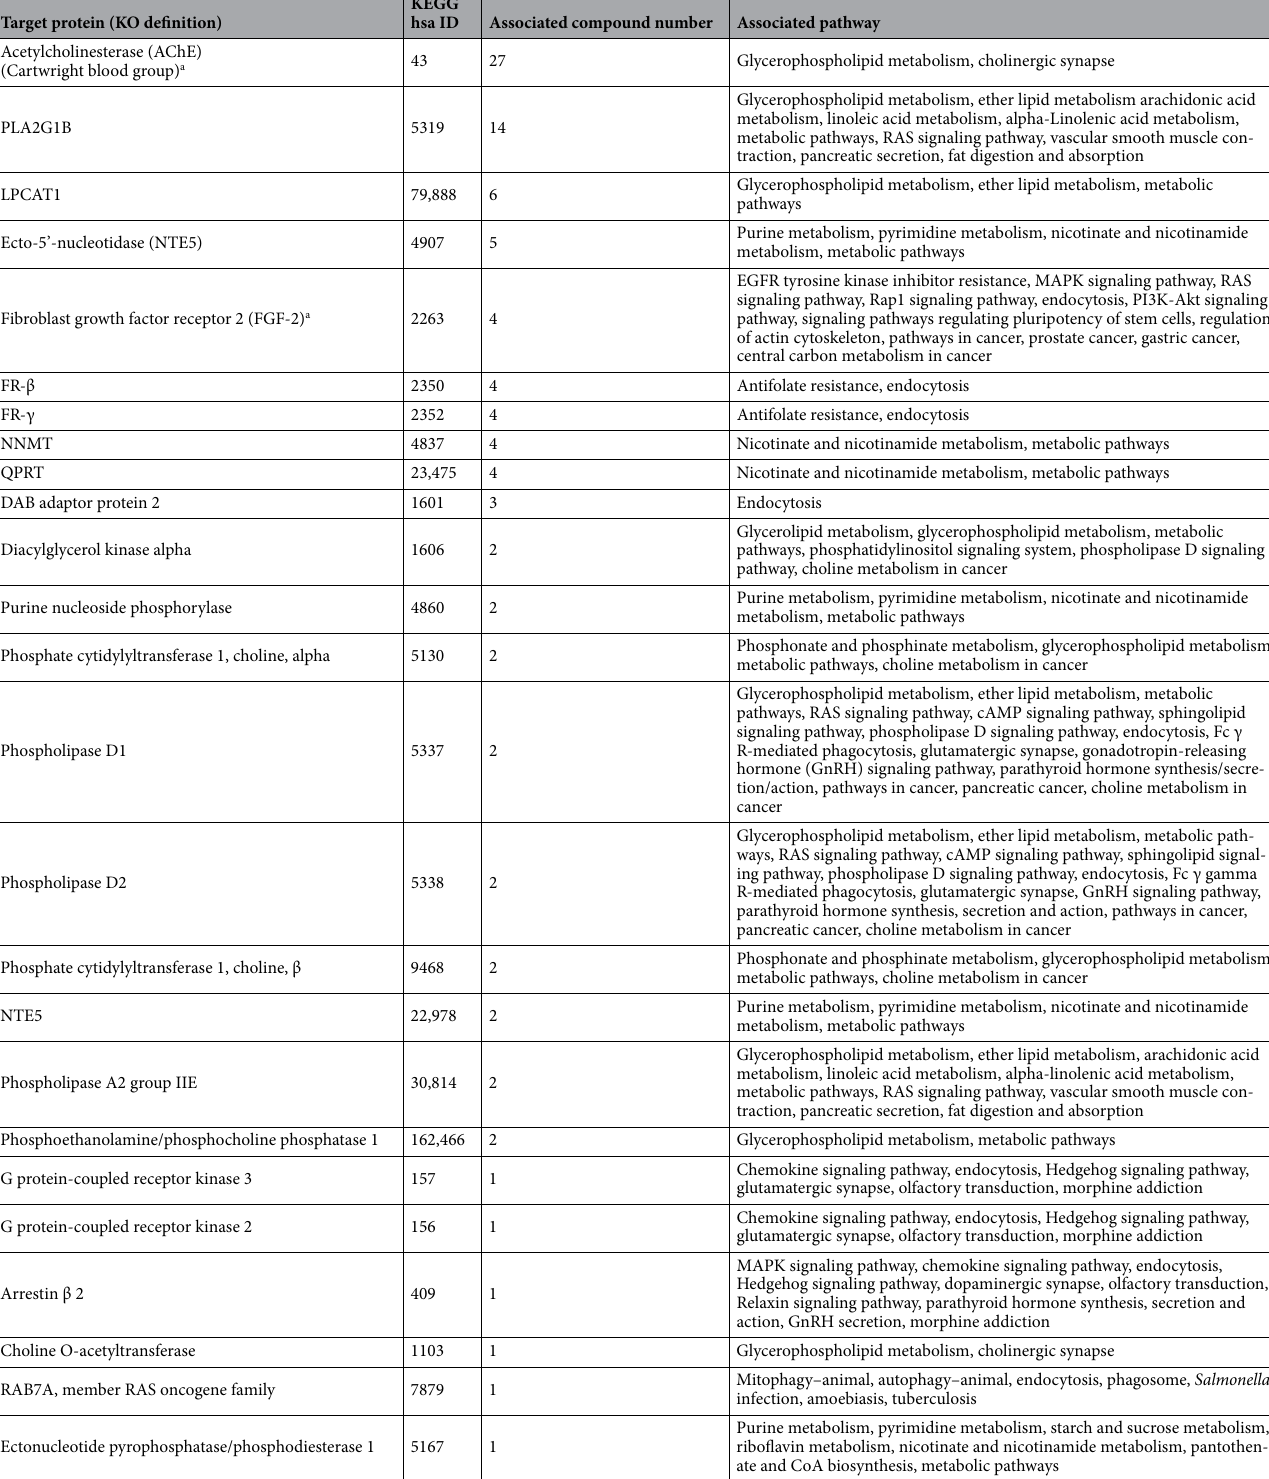
Table 3. Target protein and associated pathways. Sorted by the number of associated compounds of the target protein; hsa, Homo sapiens. a Target proteins overlapping with the Genecards database search results, i.e., AChE and FGF-2 overlapped with results when ‘alopecia’ was used as a disease keyword in the Genecards